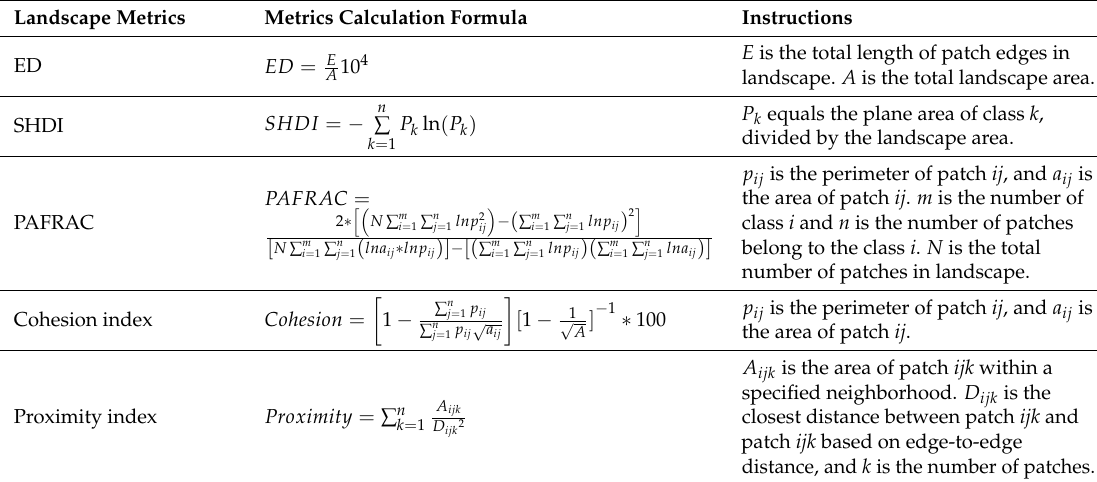
Table 1. Algorithm of some landscape metrics